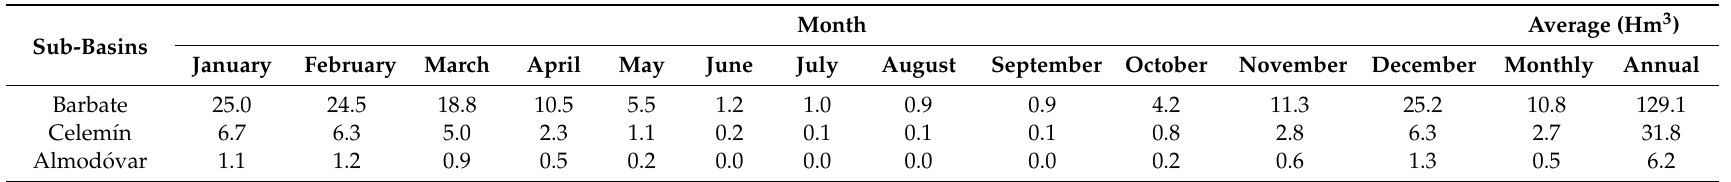
Table 3. Average monthly and annual runo ff values for the Barbate, Celem í n, and Almod ó var reservoirs (period: 1951–2017).